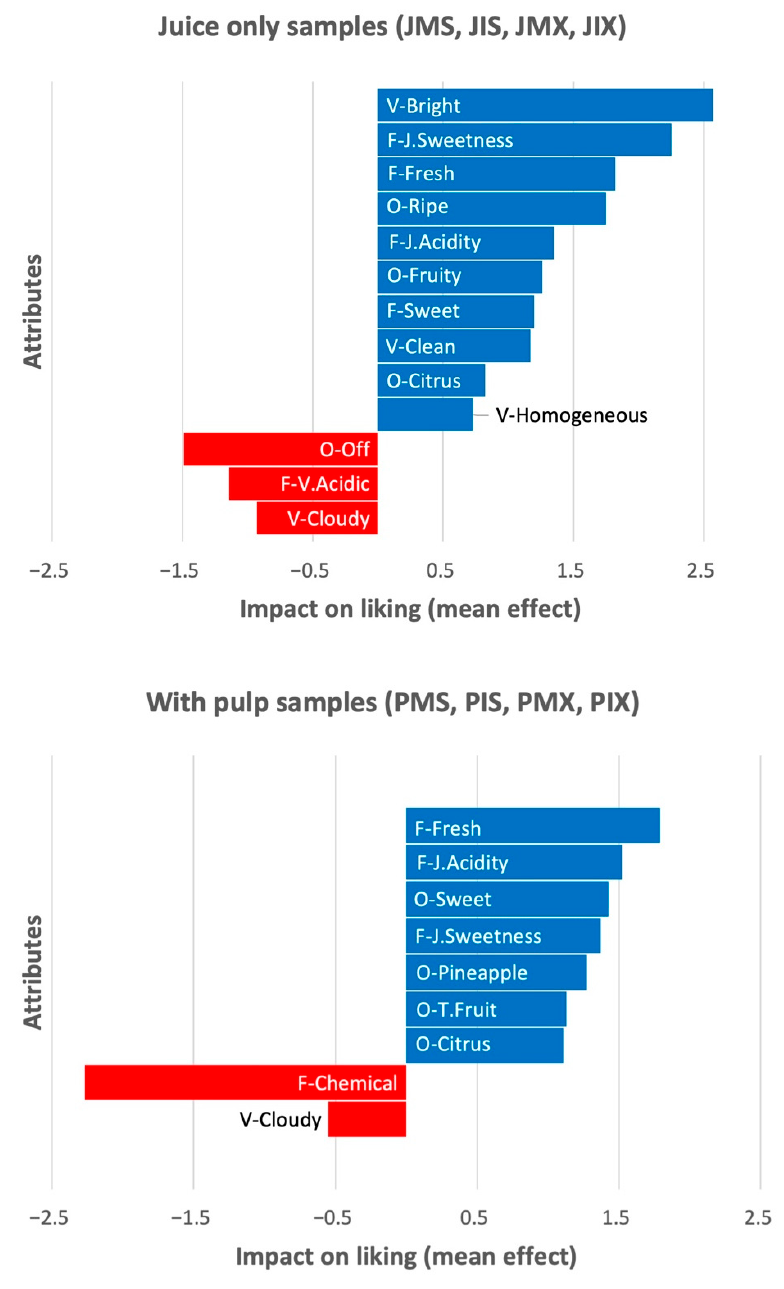
Figure 3. Penalty analysis. Attributes with a significant ( p < 0.05) positive (blue color) or negative (red color) impact on the average liking scores. P = pulp, J = juice, M = maltodextrin, I = inulin, S = stevia, and X = erythritol + xylitol + stevia.